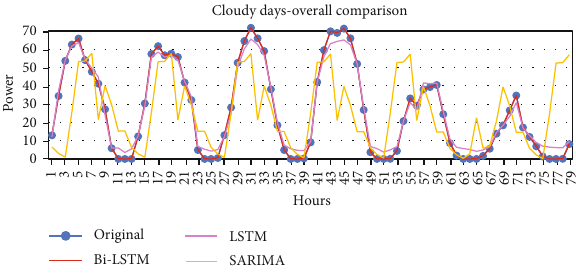
Figure 7: Forecasting results of LSTM, Bi-LSTM, and